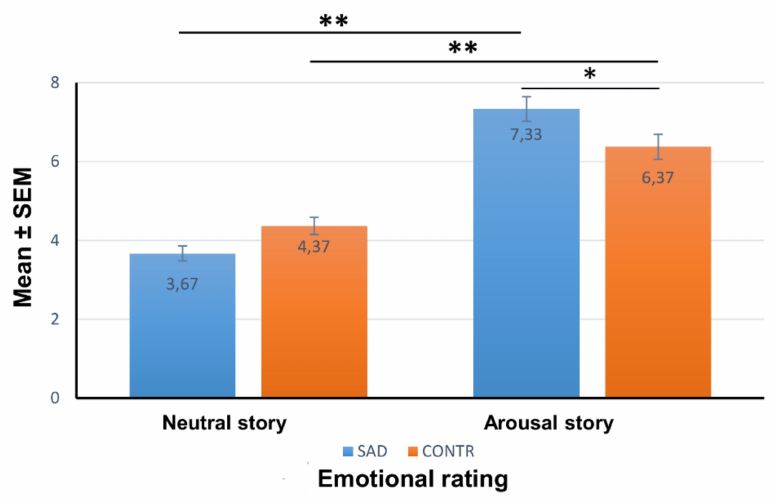
Figure 2. Emotional rating. Mean ( ± SEM) ratings of the emotional reaction to the neutral and arousal stories in the SAD and control groups. * p < 0.01; ** p <